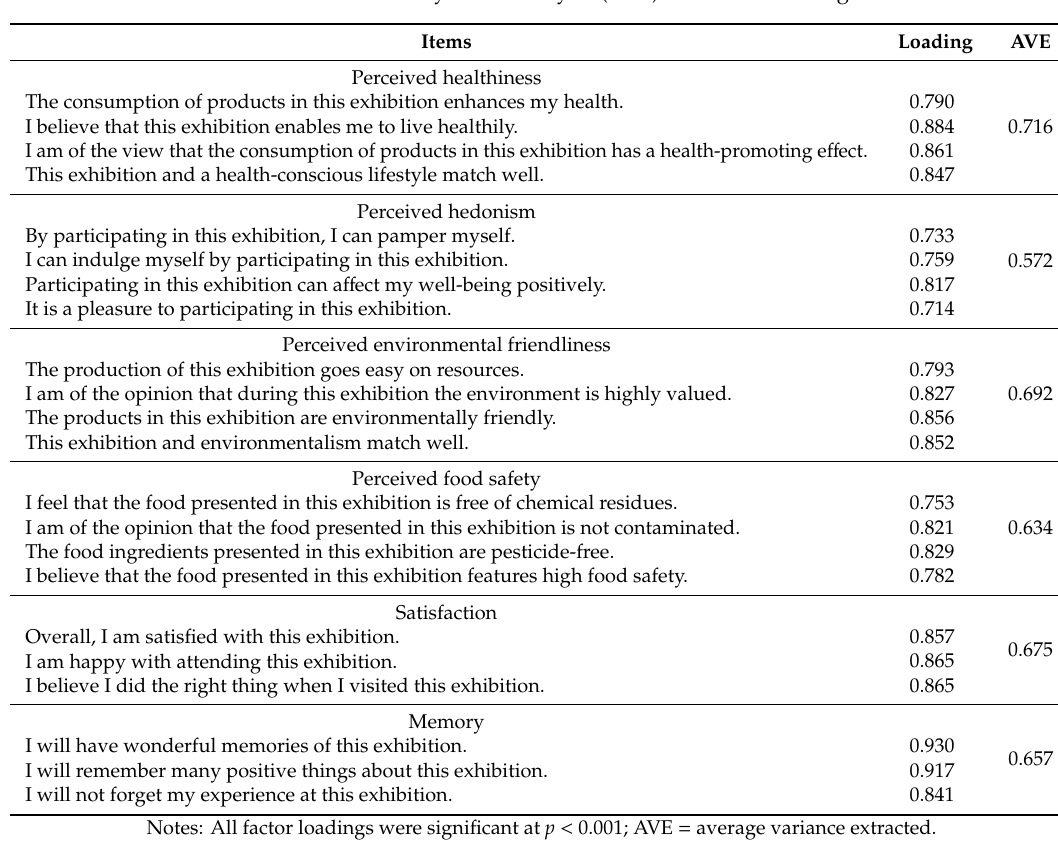
Table 3. Confirmatory factor analysis (CFA): items and loadings.